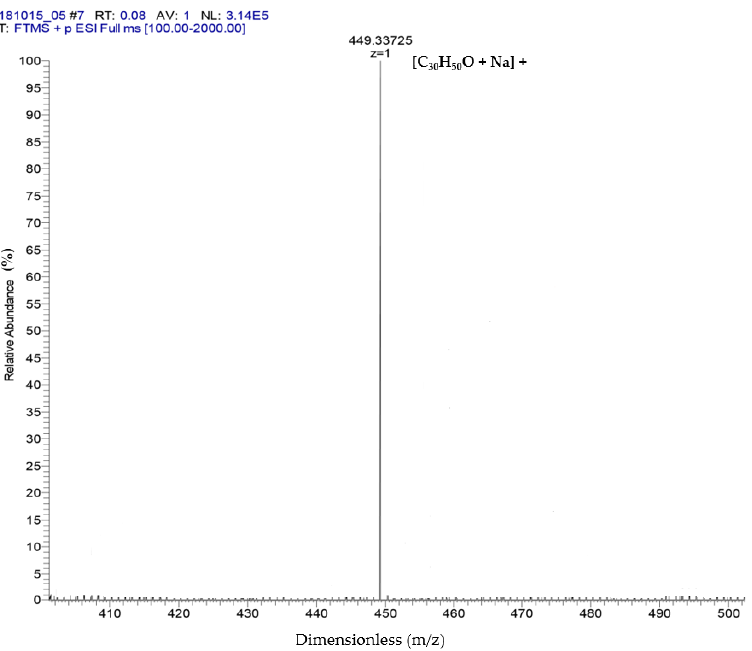
Figure 2. Identification of α -amyrin and β -amyrin by ESI-MS.